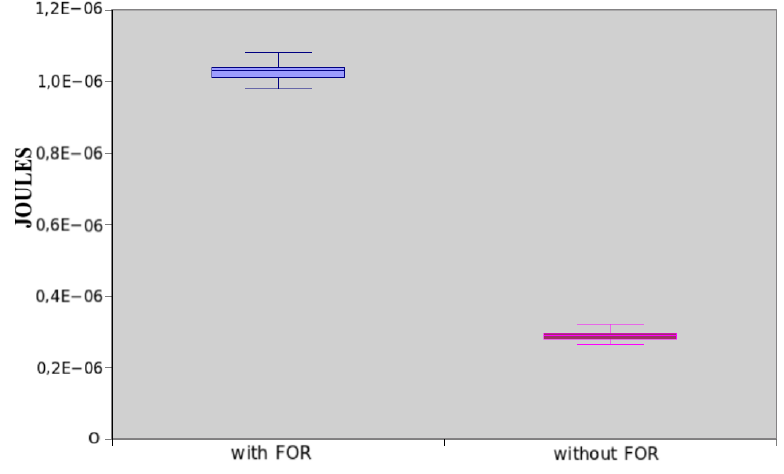
Figure 14. Power Consumption of